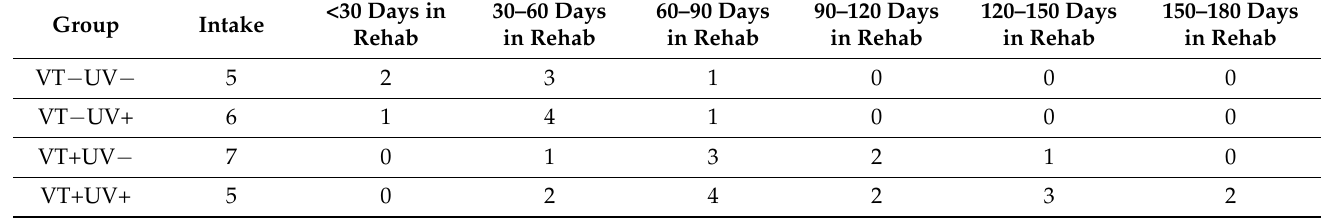
Table 2. Number of individuals sampled in each treatment group at various time points while residing at GLNC. Time points were grouped into 30-day periods. Some individuals were sampled multiple times depending on the duration they remained at GLNC. Some VT+ individuals died or were euthanized shortly after intake and so were sampled only once.